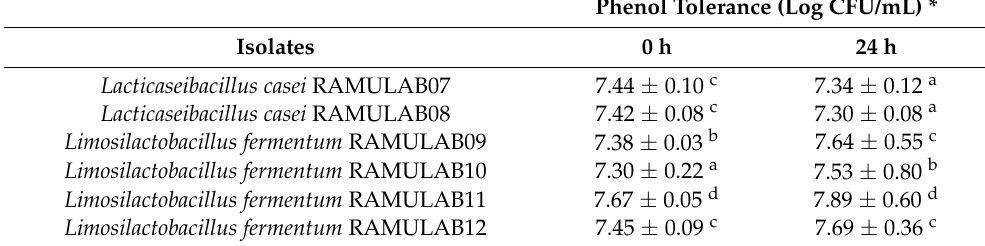
Table 2. The phenol tolerance of the